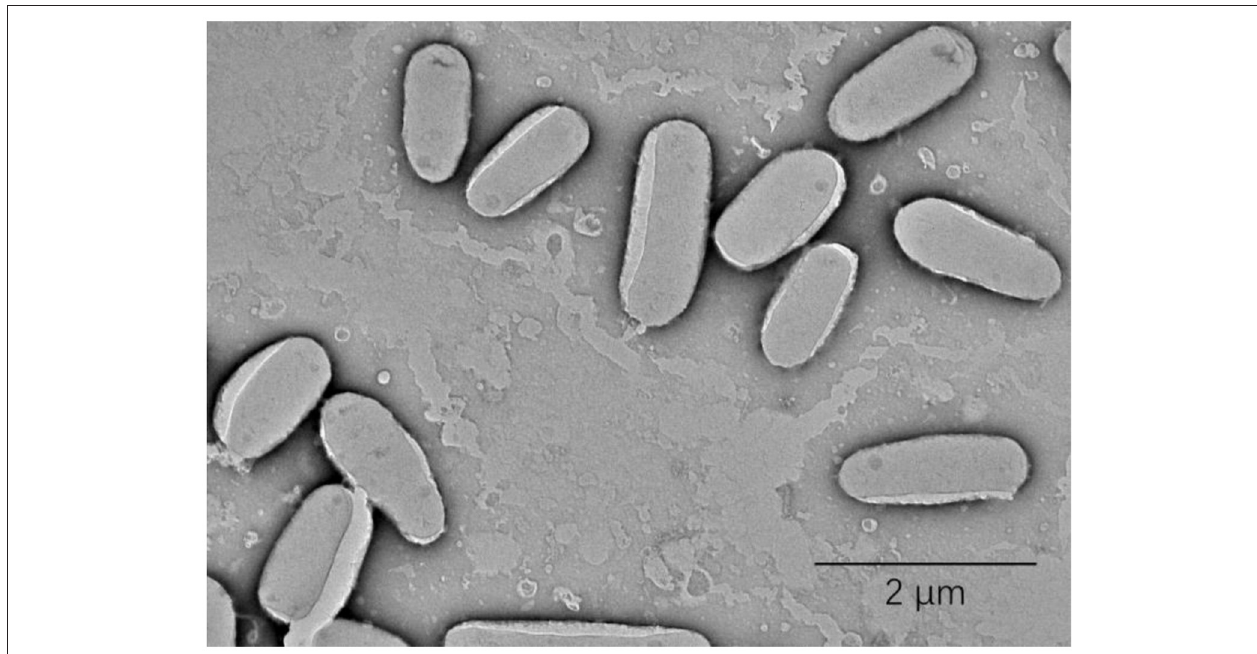
FIGURE 1 | Transmission electron microscope image of strain JXJ CY 35 T